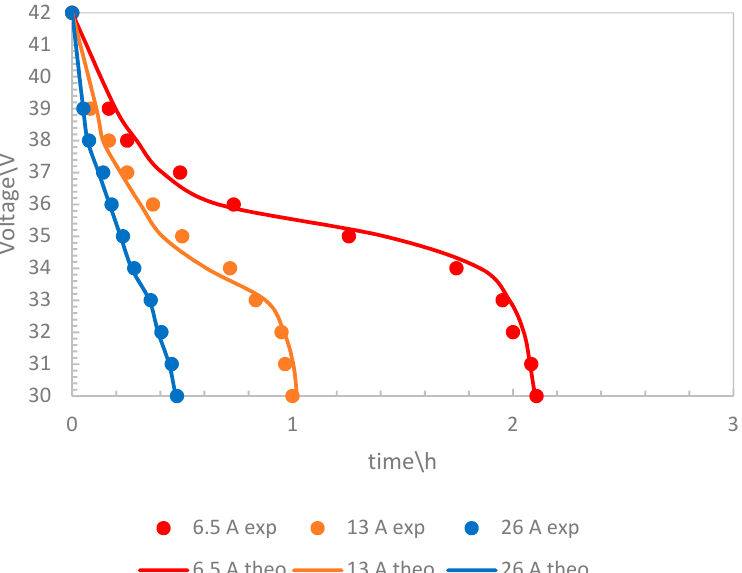
Figure 3. Comparison between the theoretical Li-ion battery pack discharge theoretical (theo) curves and the Li-ion battery pack experimental (exp) data, supplied by the manufacturer at different typical operating currents (6.5, 13, and 26 A).